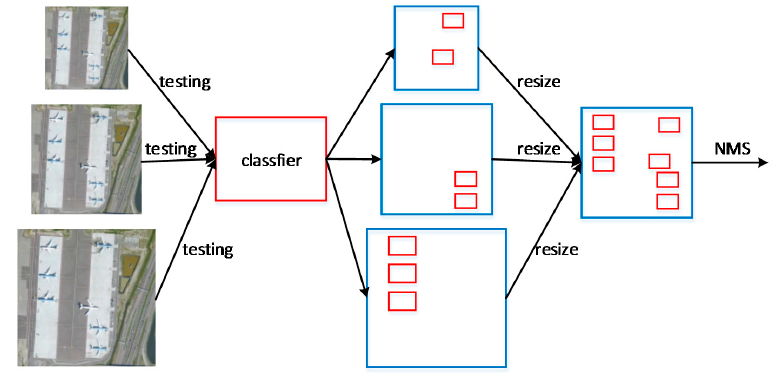
Figure 13. Strategy of the multi-scale testing.